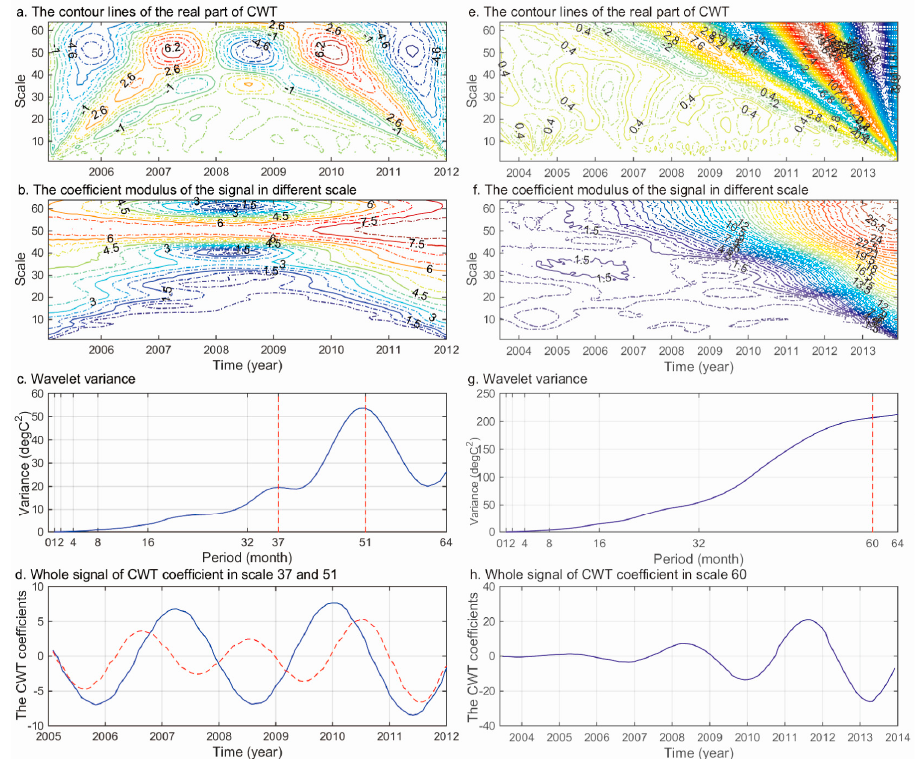
Figure 7. CWT on HHL and InSAR time series for Well 1: ( a ) the contour lines of the real part of the CWT analysis for HHL time series; ( b ) the coefficient modulus of the HHL time series in different scales; ( c ) wavelet variance curve of HHL time series; and ( d ) the CWT coefficients curve of HHL time series in different scales. ( e – h ) The same as ( a – d ) but for InSAR time series.